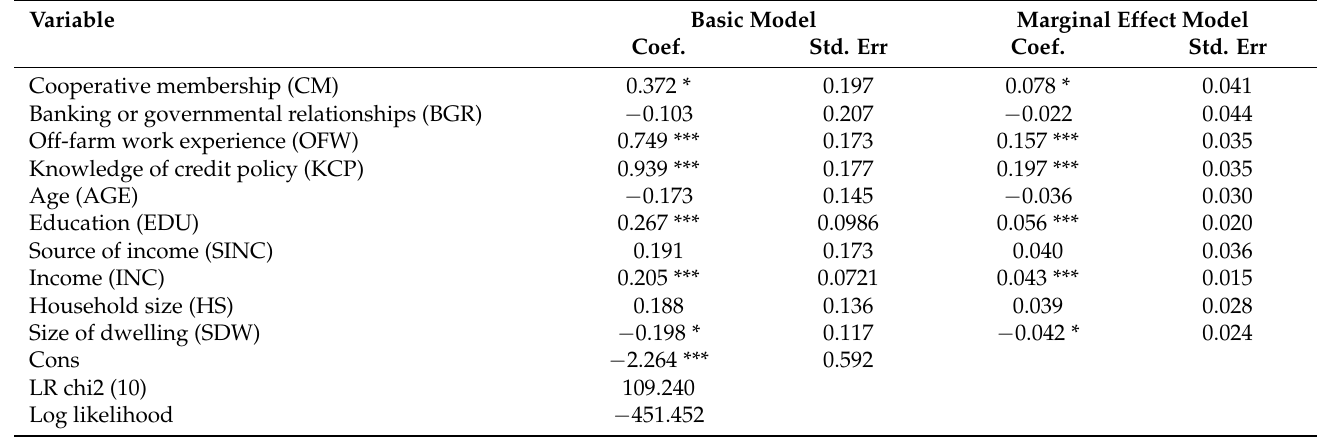
Table 3. Estimation results of factors that influence farmers’ access to bank